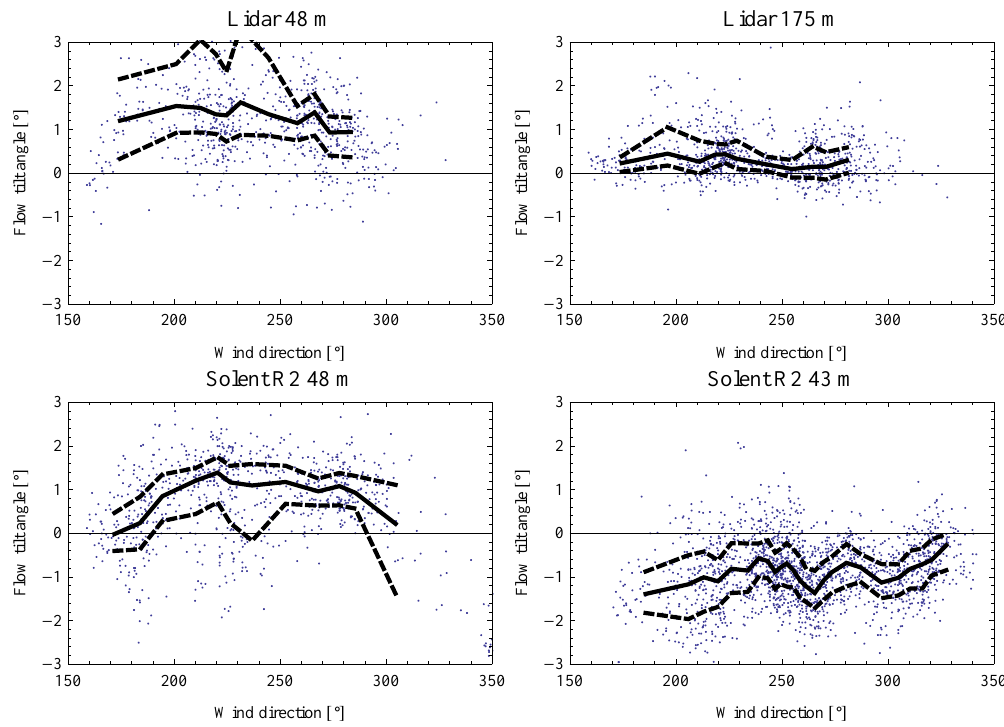
Fig. 7. Lidar and sonic comparison from Sorø. There is only one overlapping measurement height